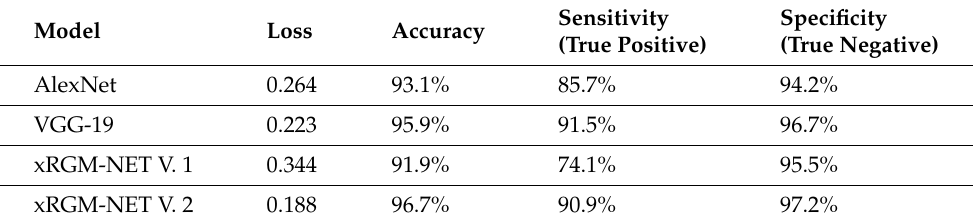
Table 1. xRGM-NET vs. other models with base data: no augmentation.